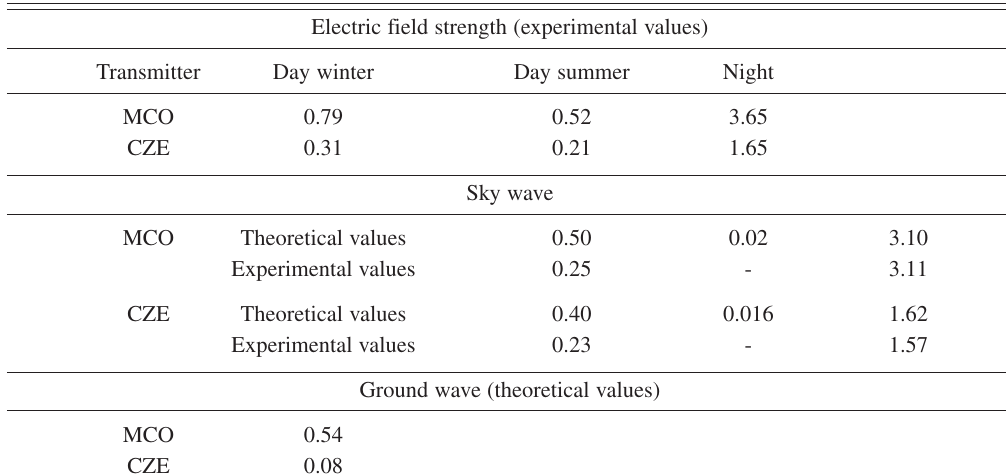
Table I. Experimental (Exp) and theoretical (Theo) values of the electric field strength (mV/m) for the MCO (216 kHz) and CZE (270 kHz) radio signals at AS